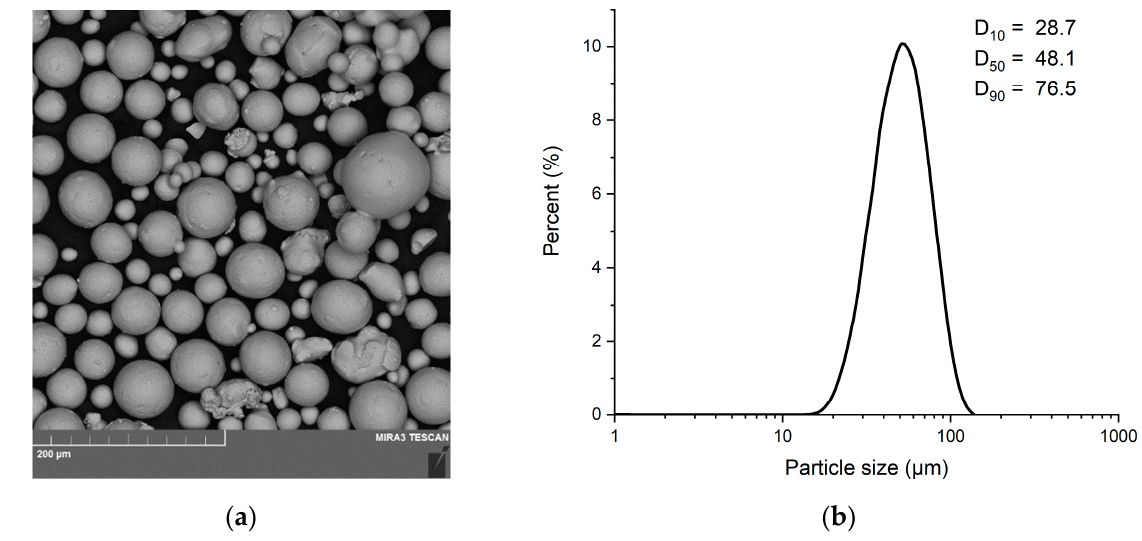
Figure 2. ( a ) SEM image of initial powder; ( b ) Initial powder particle size.